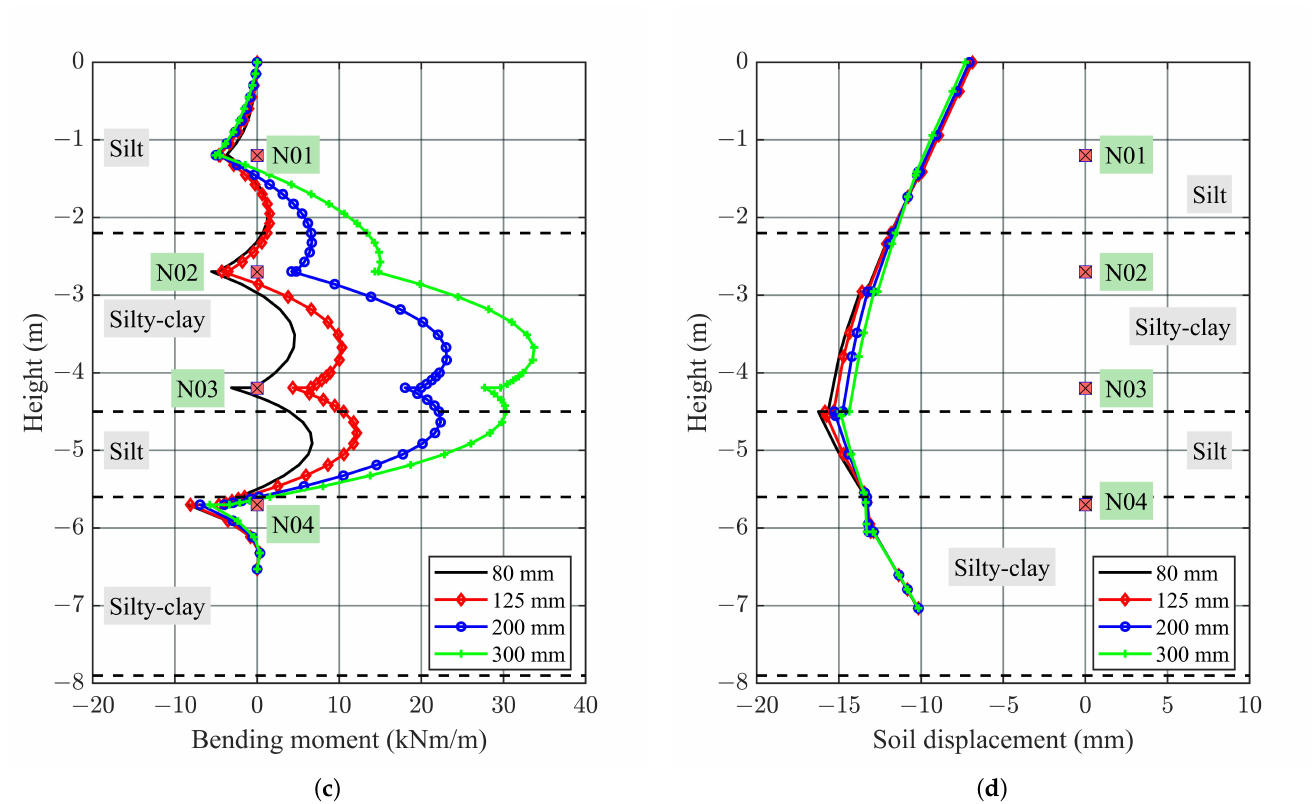
Figure 3. Facing thicknesses and responses of facing in terms of: ( a ) axial force; ( b ) shear force; ( c ) bending moment; ( d ) retained soil